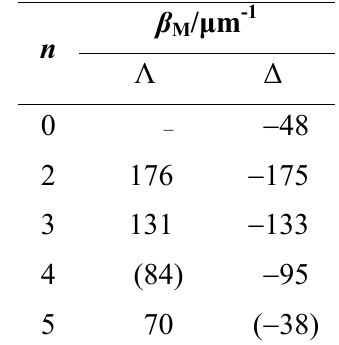
) a at room temperature of [Ru(acac) M